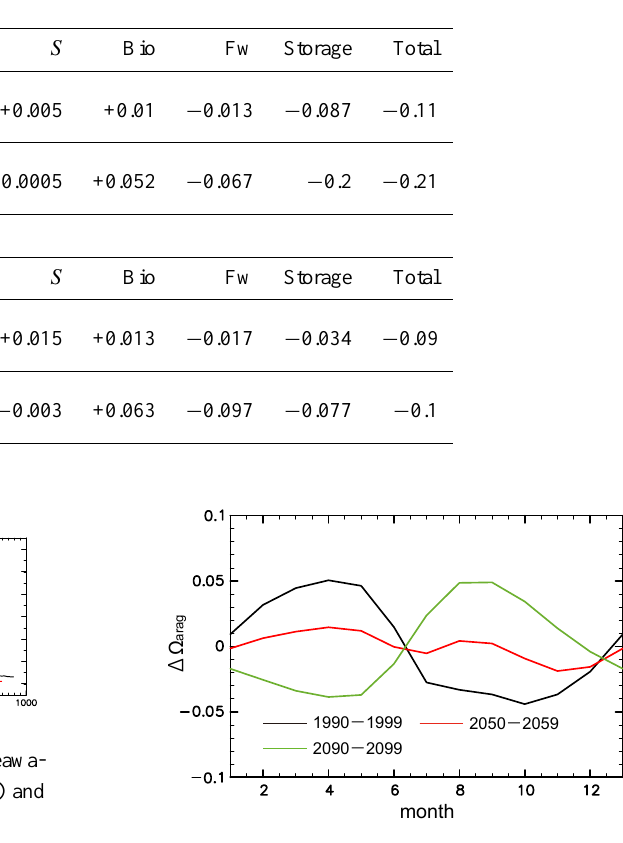
Fig. 9. Calculated seasonal deviation in (cid:127) arag in the Arctic Ocean in “CMIP5” from the annual mean for 1990–1999 (black), 2050–2059 (red), and 2090–2099